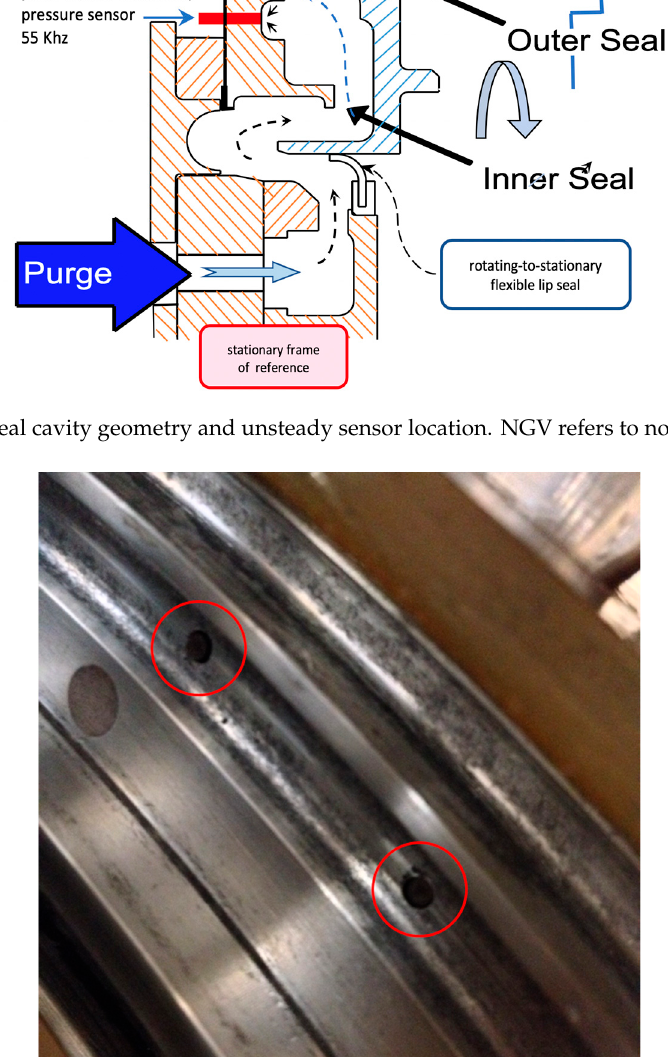
Figure 3. Flush-mounted piezo-resistive pressure transducers in rim seal cavity, 5°